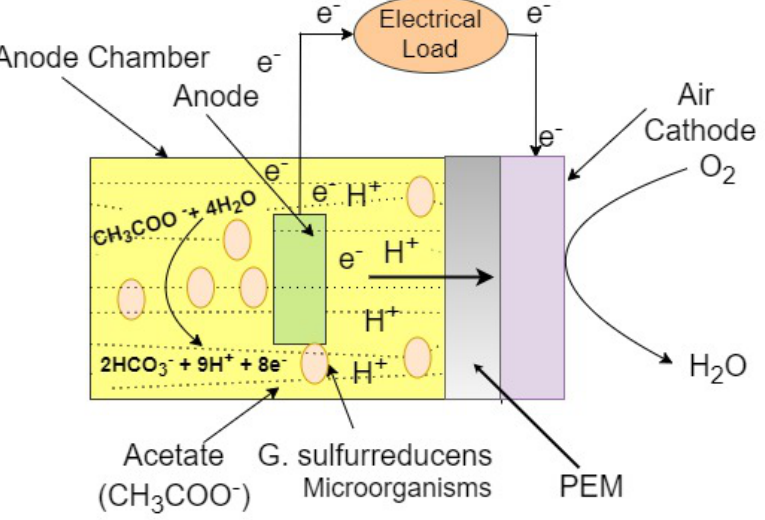
Figure 3. Single chamber MFC with PEM